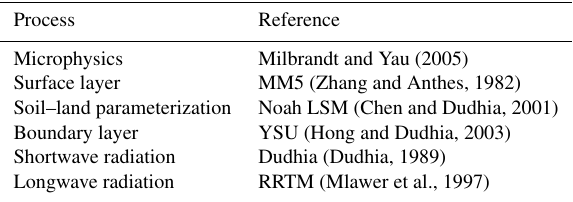
Table 1. WRF-Chem physics parametrizations used for this